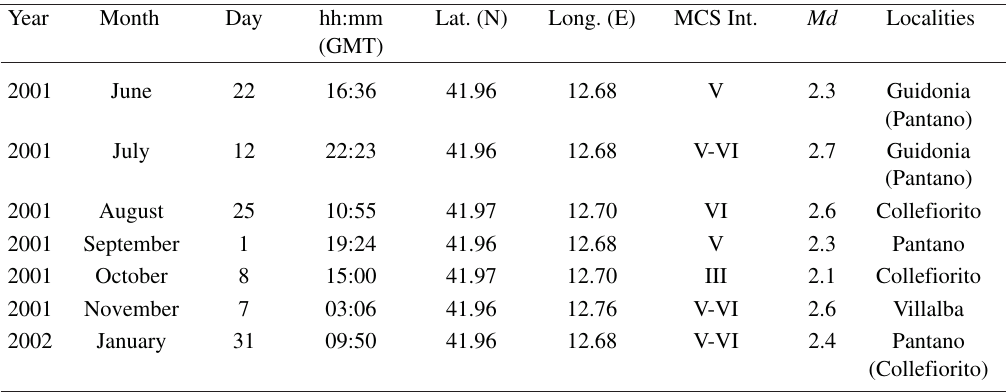
Table II. Events recorded by the Centralized National Network in the period between June 2001 and January